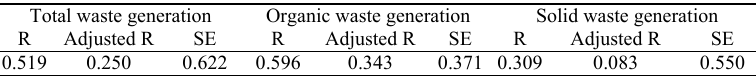
Table 5: Multiple correlation coefficients and determination coefficient